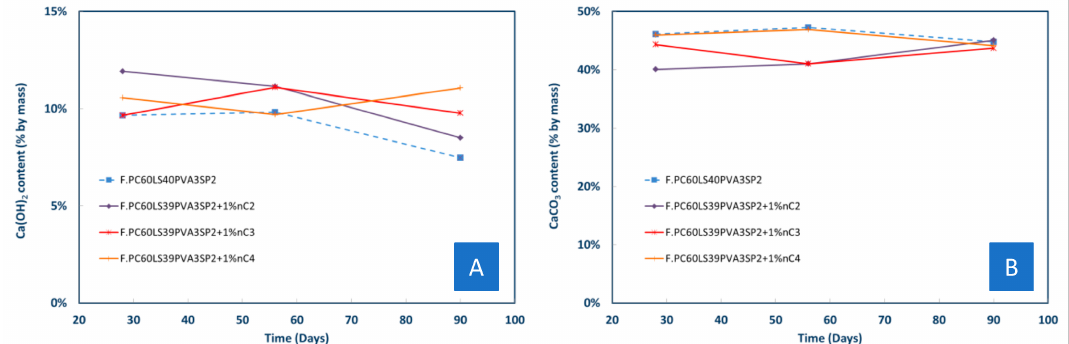
Figure 8. E ff ect of nMT type on ( A ) Ca(OH) 2 and ( B ) CaCO 3 content of fiber–cement nanohybrids based on